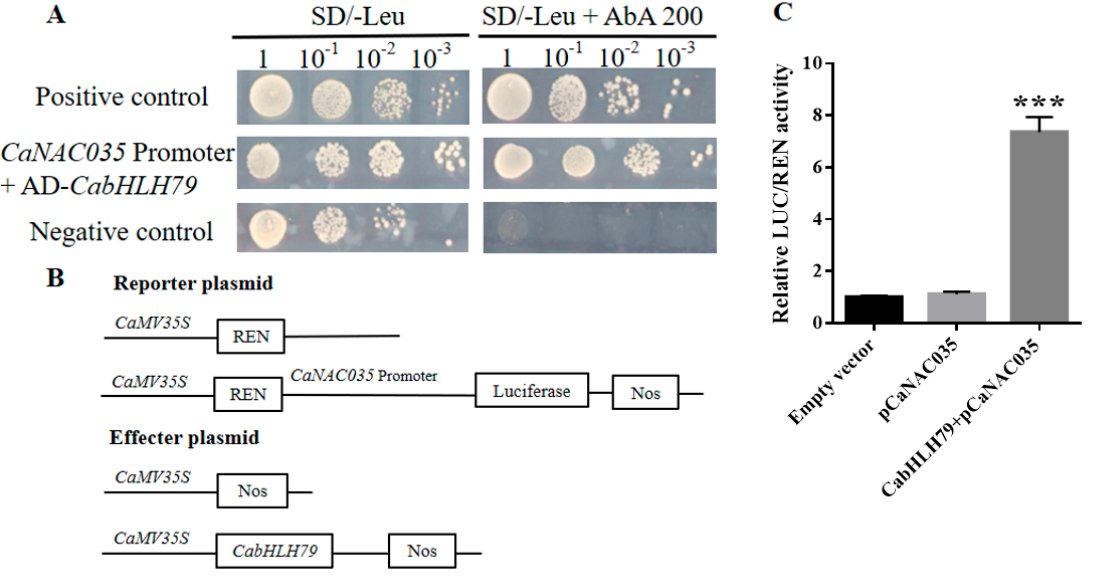
Figure 1. CabHLH79 binds to and activates the CaNAC035 promoter. ( A ) Yeast one-hybrid (Y1H) assay on binding of CabHLH79 directly to the promoter region of CaNAC035 . CaNAC035 promoter + AD − CabHLH79, insert the CaNAC035 promoter truncated segment (1 − 520 bp) into the pAbAi vector as a bait, and CabHLH79 was inserted into the pGADT7 vector as prey. pGADT7 − p53+pAbAi − p53 was a positive control and pGADT7 + CaNAC035 was a negative control. Yeast cells were grown on SD/ − Leu plates with 200 ng/ mL Aureobasidin A(AbA). ( B ) Schematic representation of the firefly luciferase (LUC) reporter vector containing the CaNAC035 promoter and the effector vectors expressing CabHLH79 under the control of the 35S promoters. The open reading frames of CabHLH79 were fused to a pGreenII 62 − SK vector. The promoter sequence of CaNAC035 was cloned into a pGreenII 0800 − LUC vector. ( C ) LUC/Renillaluciferase (REN) activities detected from the reporter system described in ( A ), testing the effects of CabHLH79 on the expres- sion of CaNAC035 . Empty vector, pGreenII 62-SK + pGreenII 0800 − LUC; pCaNAC035, pGreenII 62 − SK+promoterCaNAC035 − pGreenII 0800 − LUC; CabHLH79 +pCaNAC035, CabHLH79 − pGreenII 62 − SK+promoterCaNAC035 − pGreenII 0800 − LUC. All data of three independent biological repli- cates were expressed by Means ± SDs. * representing significant difference (*** p < 0.001).